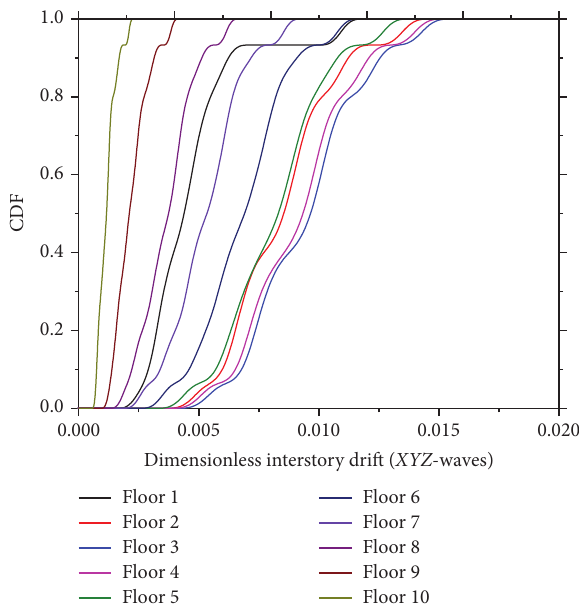
Figure 13: The CDF of the dimensionless interstory drift story for the 10-story building under XYZ directions